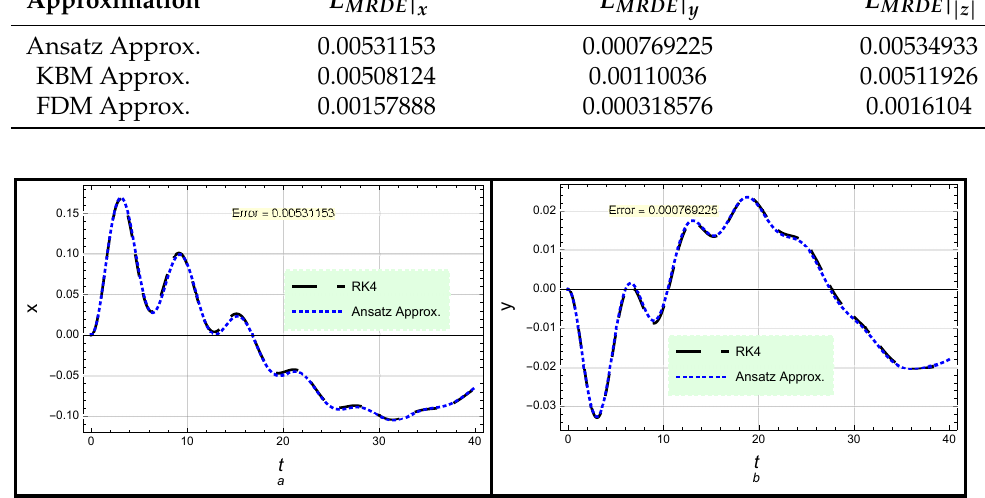
Fig. 1 Figure 1. Both the analytic approximation (29) using the ansatz method and the RK4 approximation to the i.v.p. (6) for ( a ) the real and ( b ) imaginary components ( x , y ) are considered.